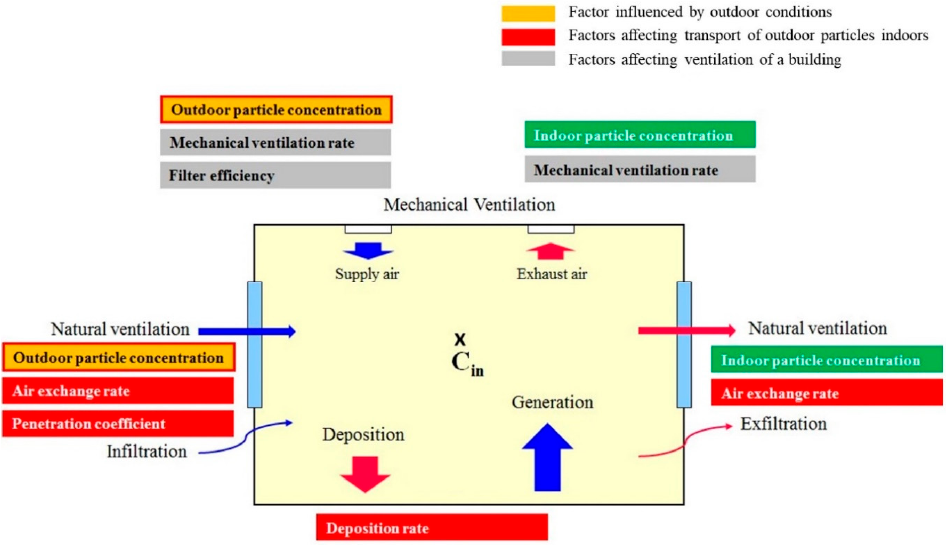
Figure 2. Factors related to particle transport from outdoors to indoors.